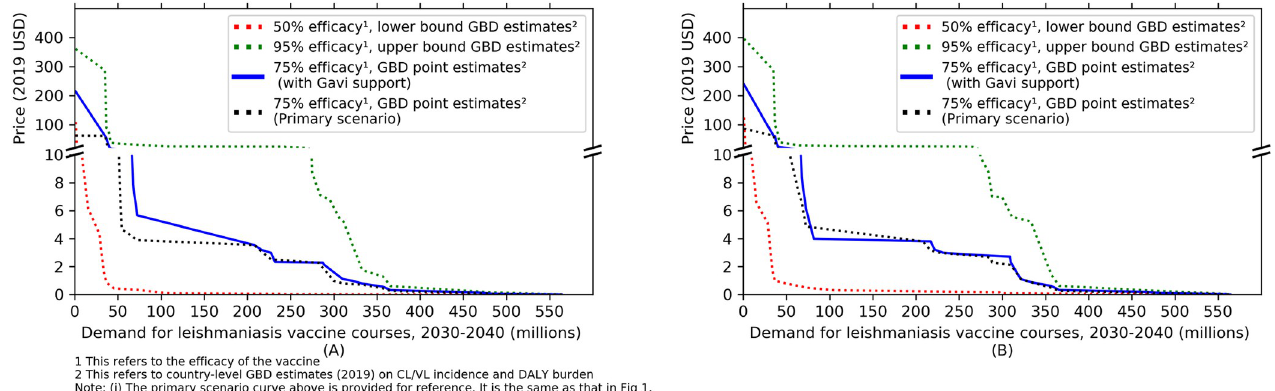
Fig 2. Illustrative global demand curve for a leishmaniasis vaccine between 2030 and 2040 including Gavi support: (A) assuming treatment coverage = 0%, (B) assuming treatment coverage = 100%.